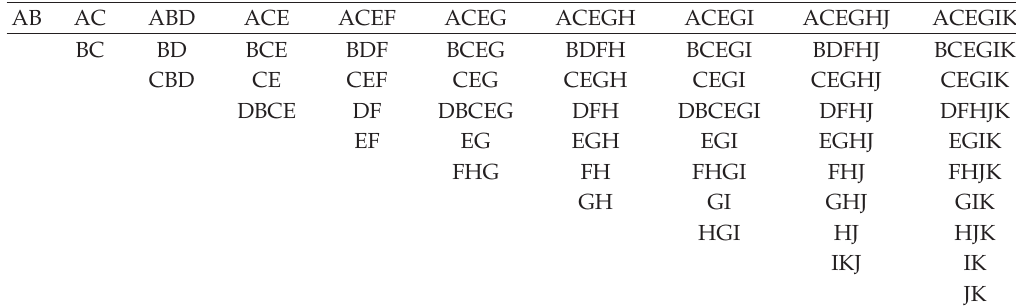
Table 2: Table of